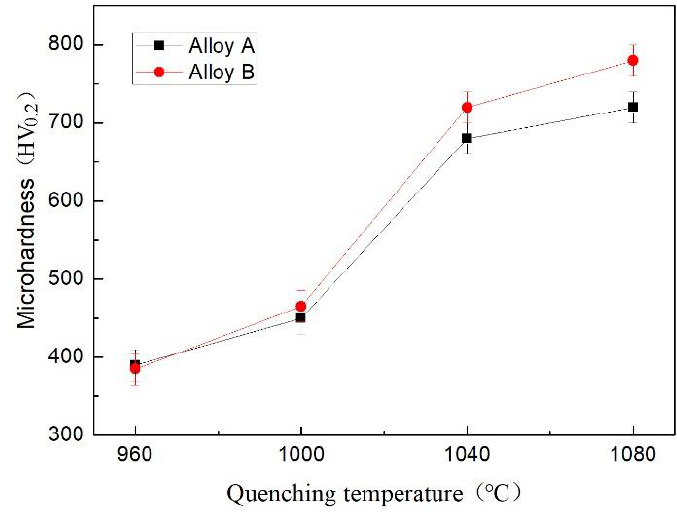
Coatings 2022 , 12 , x FOR PEER REVIEW 8 of 12